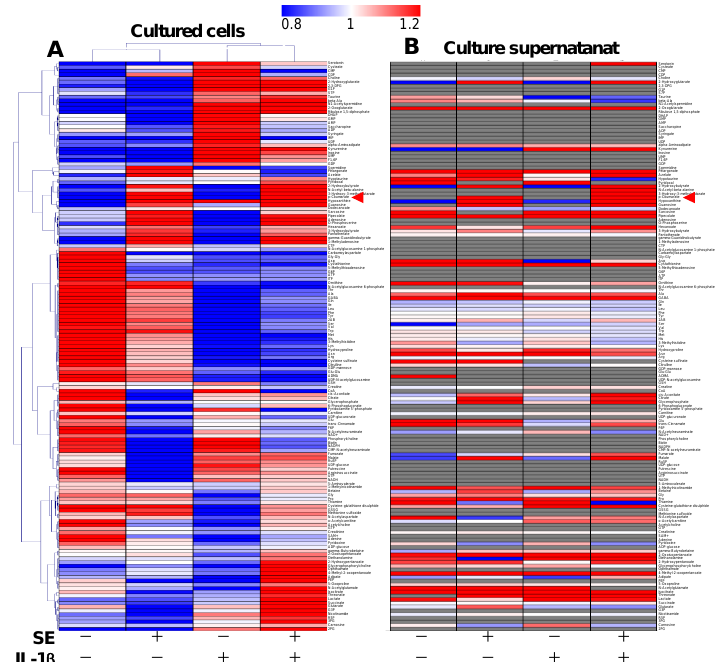
Figure 2. Metabolomic analysis of HGF cells incubated for 3 h without (control) (column 1) or with SE (2%) (column 2), IL-1 β (3 ng/mL) (column 3) and SE (2%) + IL-1 β (3 ng/mL) (column 4). The averaged concentrations of samples ( n = 4) for each condition are visualized. To determine the color, the average concentration was calculated for each metabolite, and individual metabolite concentration was divided by the average. The metabolites of the cultured cell ( A ) were aligned by the clustering with Pearson Correlation, and the metabolites of the supernatant ( B ) were aligned according to the data in ( A ). The numbers of cells recovered per dish are 1.06 ± 0.086 × 10 6 , 1.16 ± 0.068 × 10 6 , 1.21 ± 0.12 × 10 6 , and 1.12 ± 0.053 × 10 6 , respectively. Blue, white, and red indicate fold changes of 0.8, 1, and 1.2, respectively, compared to the average of each metabolite. The gray indicates that the corresponding metabolite is not detected. The names of metabolites can be visible by 4-fold magnification with zooming. Original data are available in Supplemental Table S1.